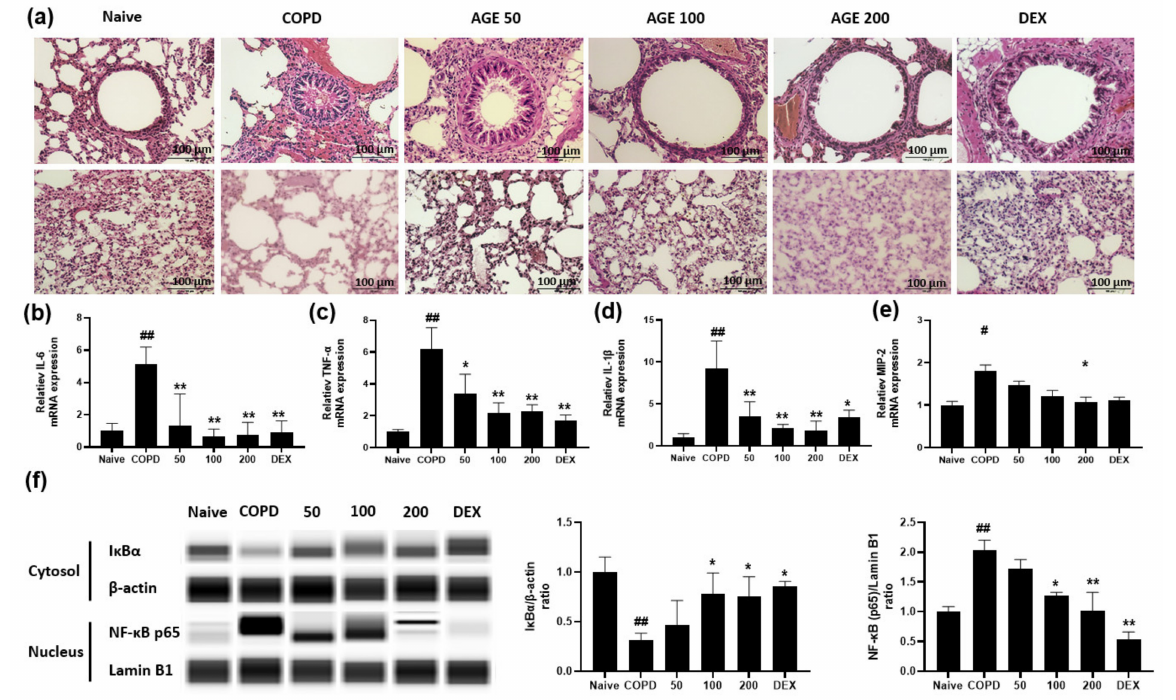
Figure 5. Effect of the Artemisia gmelinii ethanol extract (AGE) on airway inflammation and alveolar enlargement, cytokines and chemokines, and the activation of NF- κ B pathways in lung tissues from the CSE (100%)/PPE (1.8 U/Head)-induced COPD mice. Following the schedule in Figure 4a, lung tissues from each group were collected and used to assess the airway inflammation and alveolar enlargement, cytokines and chemokines, and the activation of NF- κ B pathways. The airway in- flammation and alveolar enlargement ( a ) were measured by hematoxylin and eosin staining and all images were taken at × 200 magnification (scale bar: 100 µ m). The mRNA levels of IL6 ( b ), TNF α ( c ), IL1 β ( d ), and MIP2 ( e ) were measured by quantitative real-time polymerase chain reaction. I κ B α , NF- κ B p65, β -actin, and lamin B1 ( f ) were assessed and quantitative data were analyzed using Protein Simple capillary immunoassay (WES). Data are presented as means ± SEM.